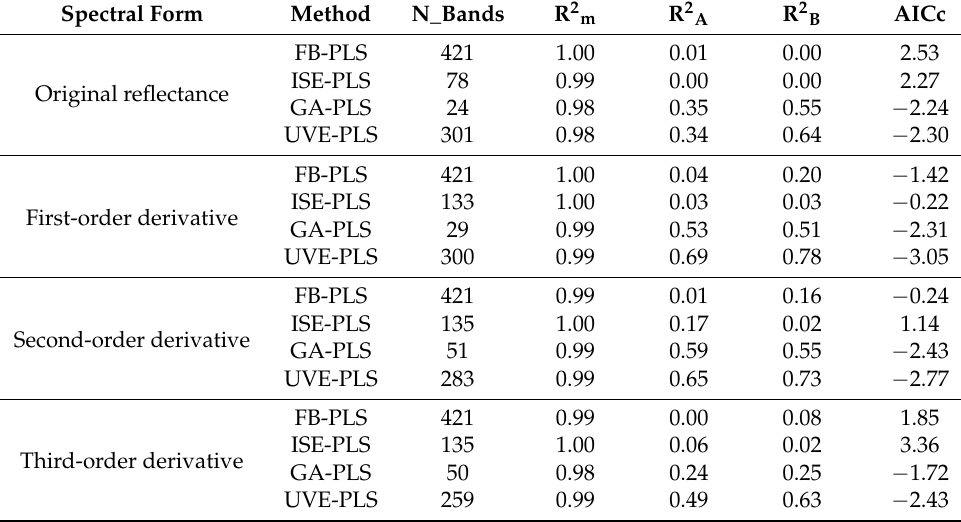
Table 2. PLSR model performance in estimating LNC from spectra within 400–2500 nm with differ- ent band-selection methods. The number of bands (N_bands) used in each PLSR model and the coefficient of determination values for the simulation dataset (R 2m ), dataset A (R 2A ), and dataset B (R 2B ) are shown in the table.